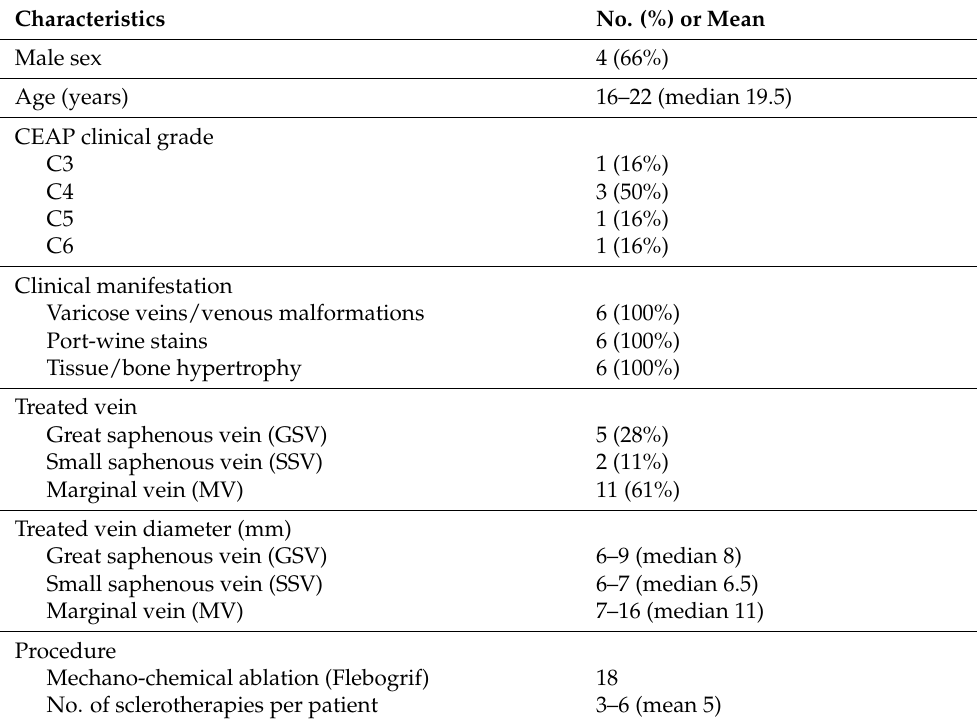
Table 1. Demographic data of the study